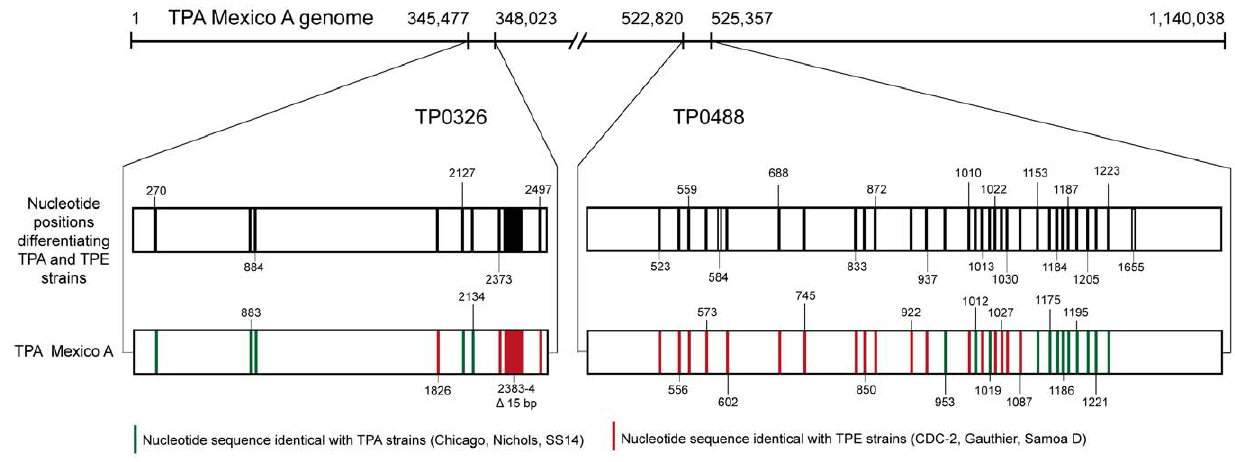
Figure 1. A schematic representation of the TPAMA_0326 and TPAMA_0488 loci. The Mexico A sequence was compared to three TPA (Nichols, SS14, and Chicago) and three TPE CDC-2, Gauthier, Samoa D) strains. Black vertical lines represent nucleotide positions differentiating all TPA and TPE strains. Green and red vertical lines represent nucleotide changes present in all analyzed TPA and TPE strains where the TPA Mexico A sequence is identical to TPA and TPE strains, respectively. Two nucleotide positions (584, 1655) in the TP0488 locus were found only in the Nichols and Chicago strains and not in the SS14 genome (open vertical lines). The symbol D stands for 15-bp deletion present in the TPE and Mexico A strains in the TP0326 gene.